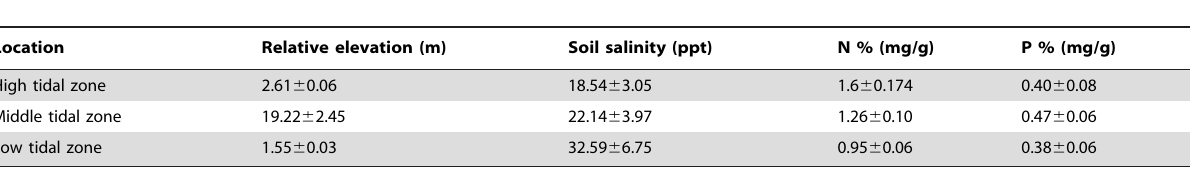
Table 2. Physical characteristics in the different tidal zones (n=30 plots) (mean 6 SE).